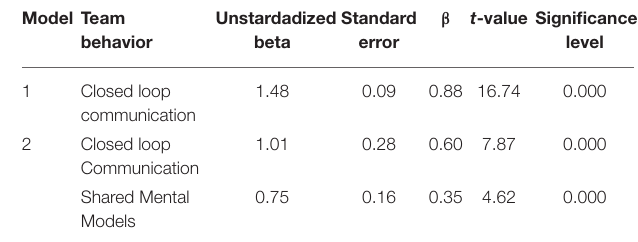
TABLE 5 | Hierarchical regression analyses of situation awareness regressed upon closed loop communication and shared mental